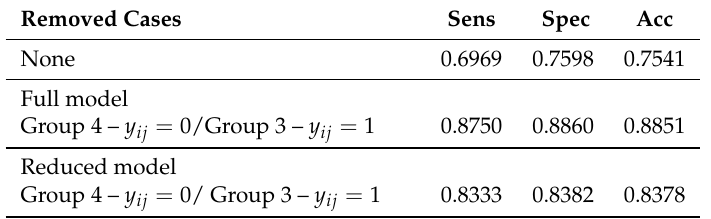
Table 13. Sens, Spec and Acc measures under data-influence analytics for the asthma